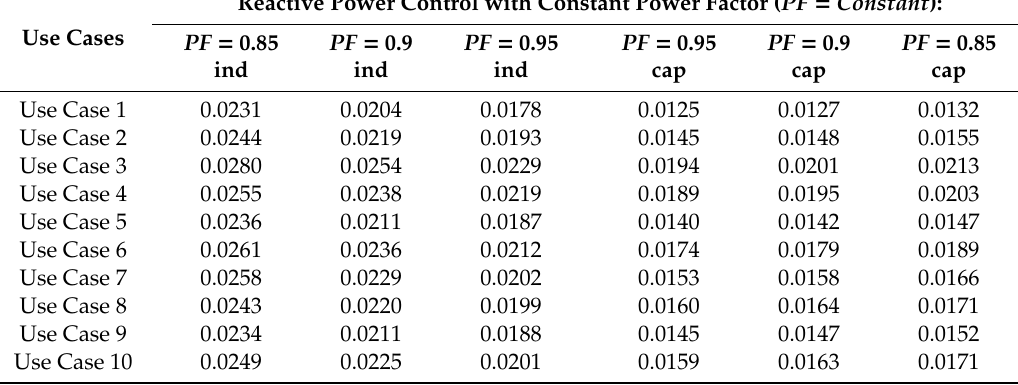
Table A5. Reactive power control with constant power factor: